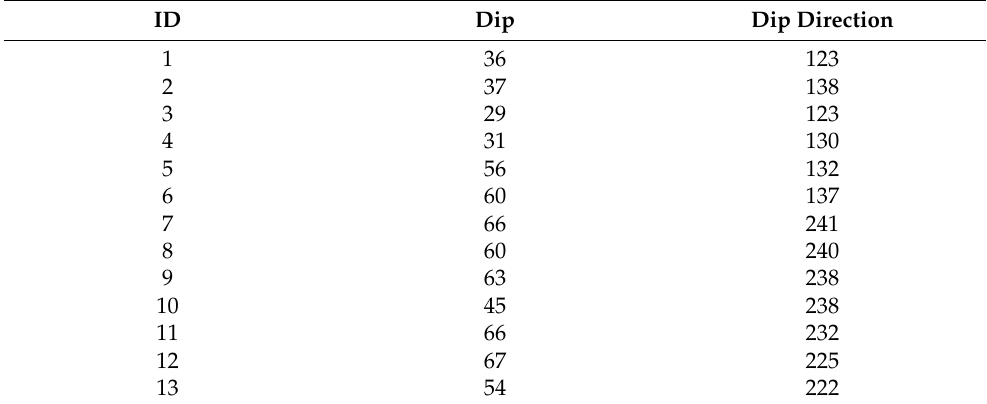
Table 3. Critical dip vectors for slope dip direction between 124 ◦ and 148 ◦ και 226 ◦ –246 ◦ for the island of Thasos.